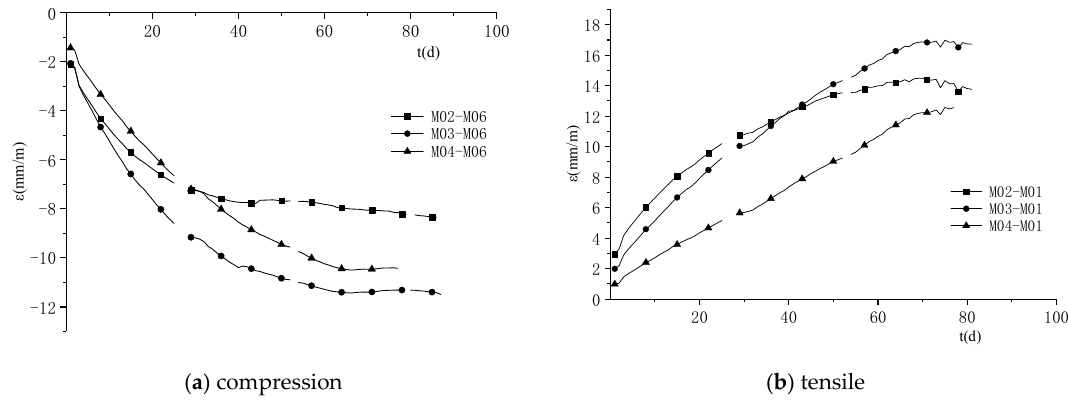
Figure 10. Non-uniform compressive and tensile deformation curves.